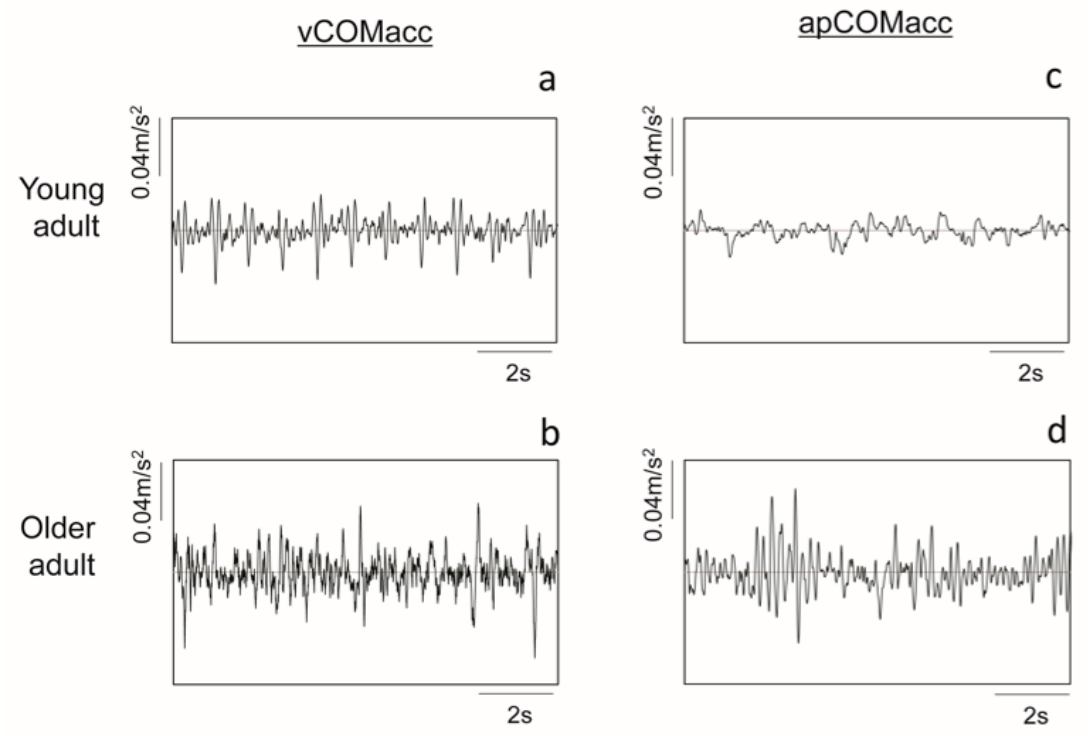
Figure 1. Representative time series of vertical center of mass acceleration (vCOMacc) (left panel—( a , b )) and anterior-posterior center of mass acceleration (apCOMacc) (right panel—( c , d )) from a young adult (upper panel) and an older adult (lower panel) for standing.